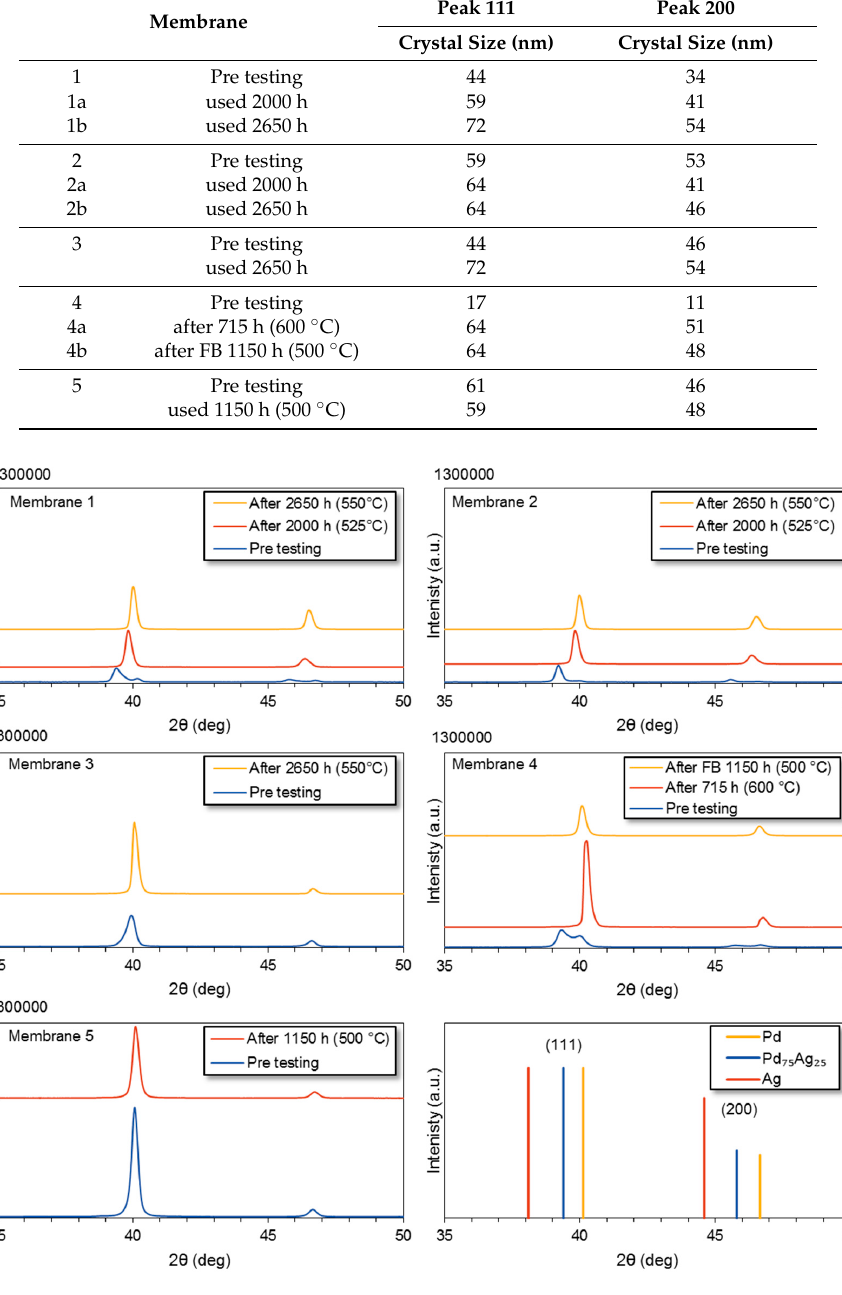
Figure 12. XRD profiles of the different membranes before and after testing.